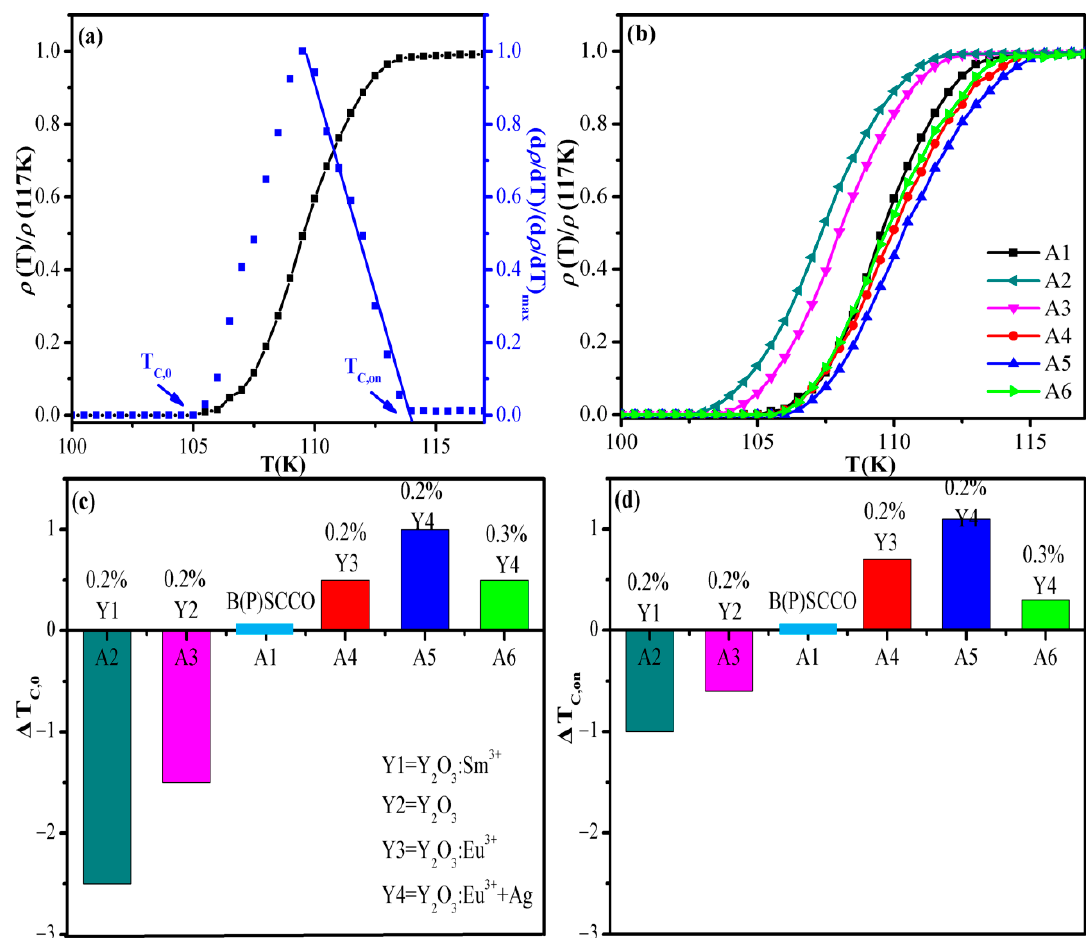
Figure 4. Superconductivity of A series samples. ( a ) Temperature dependence of normalized d ρ / dT of pure B(P)SCCO (A1). ( b ) Temperature-dependent normalized resistivity curves of pure B(P)SCCO (A1) and B(P)SCCO doped with 0.2 wt% Y 2 O 3 :Sm 3+ (A2), 0.2 wt% Y 2 O 3 (A3), 0.2 wt% Y 2 O 3 :Eu 3+ (A4), 0.2 wt% Y 2 O 3 :Eu 3+ +Ag (A5), and 0.3 wt% Y 2 O 3 :Eu 3+ +Ag (A6). ( c , d ) The Δ T C, 0 and Δ T C,on of A2, A3, A4, A5, and A6 relative to A1.